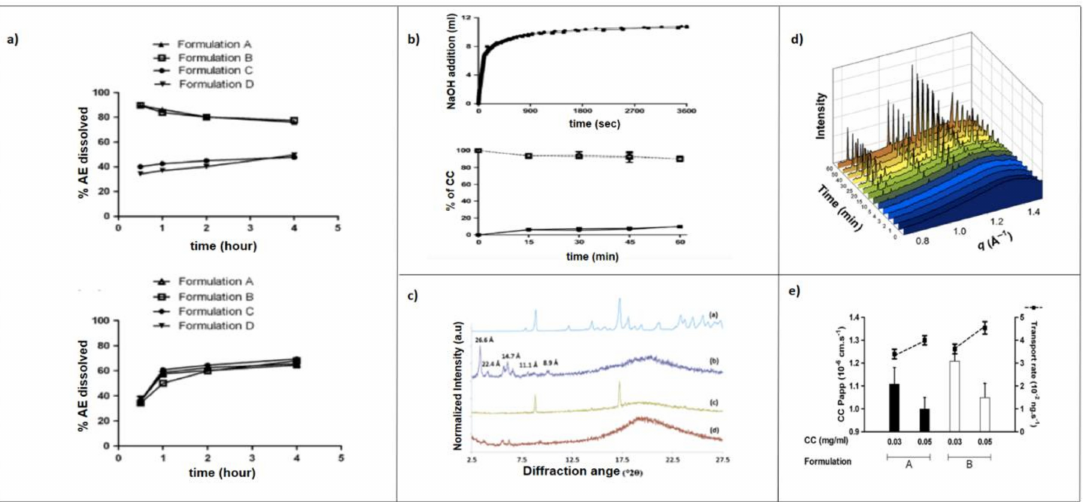
Figure 5. ( a ) Solubilization and stability of beta-Arteether in 0.1 N HCl (pH = 1) (top) and in phosphate bu ff er (pH = 6.8) (bottom) as a function of time. Each point represents the mean ± SD ( n = 3). From [41]. ( b ) Quantity of 0.2 M NaOH added to titrate the fatty acids that were released during lipid digestion (top) and the distribution profile of curcumin in the aqueous phase (open shapes and dotted lines) and in the pellet phase (filled shapes and lines) as a function of lipolysis time (bottom). From [40]. ( c ) The X-ray powder di ff raction patterns of (a) crystalline, (b) CC pellet, (c) blank pellet spiked with CC and (d) blank pellet from the lipolysis of a SNEDDS formulation. The numbers over the peaks indicate d-spacings. From [40]. ( d ) In situ SAXS profiles during the lipolysis of the MC-SNEDDS formulation containing fenofibrate. Drug precipitation was evident at 4 min after the addition of pancreatic lipase, with the characteristic di ff raction peaks for fenofibrate. From [123]. ( e ) Apparent permeability and transport rate of curcumin-loaded SEDDS across Caco-2 monolayers with two di ff erent drug concentrations (0.03 and 0.05 mg / mL). From